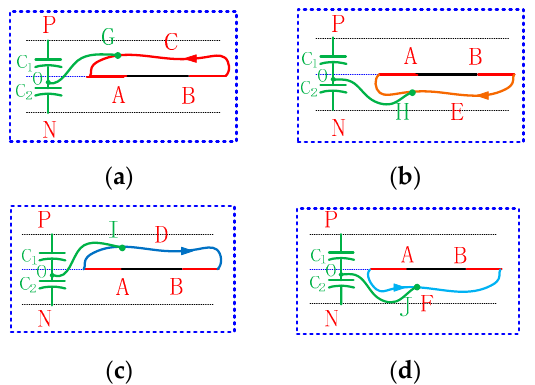
Figure 21. Indirect Connection NPC cell under DFUSPWM. ( a ) PFT mode; ( b ) PFB mode; ( c ) NFT mode; ( d ) NFB mode.